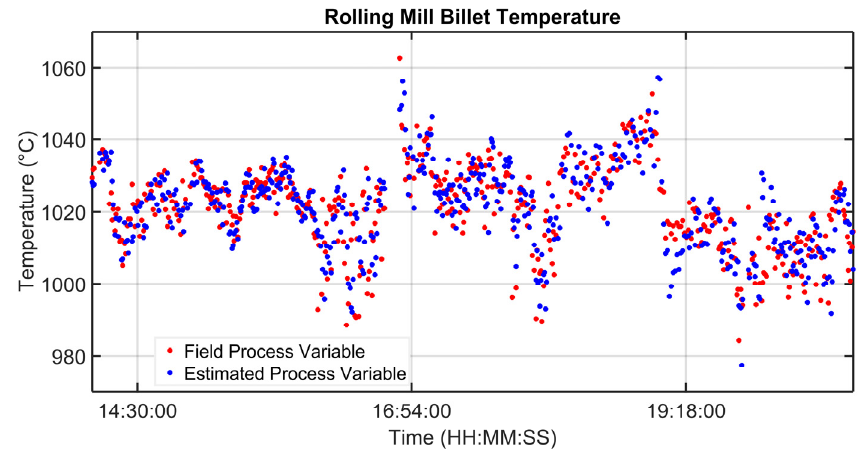
Figure 4. Modelization results: zone 3 temperature PV model.